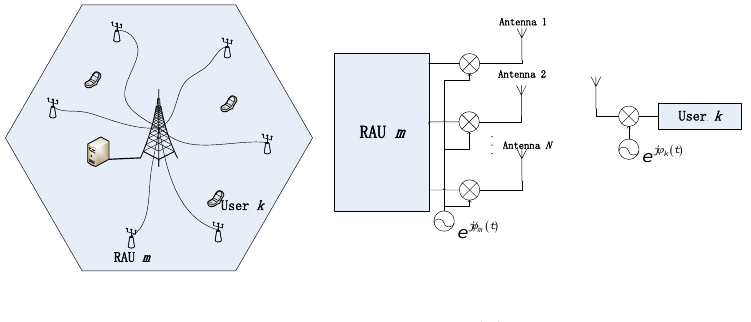
Figure 1. System